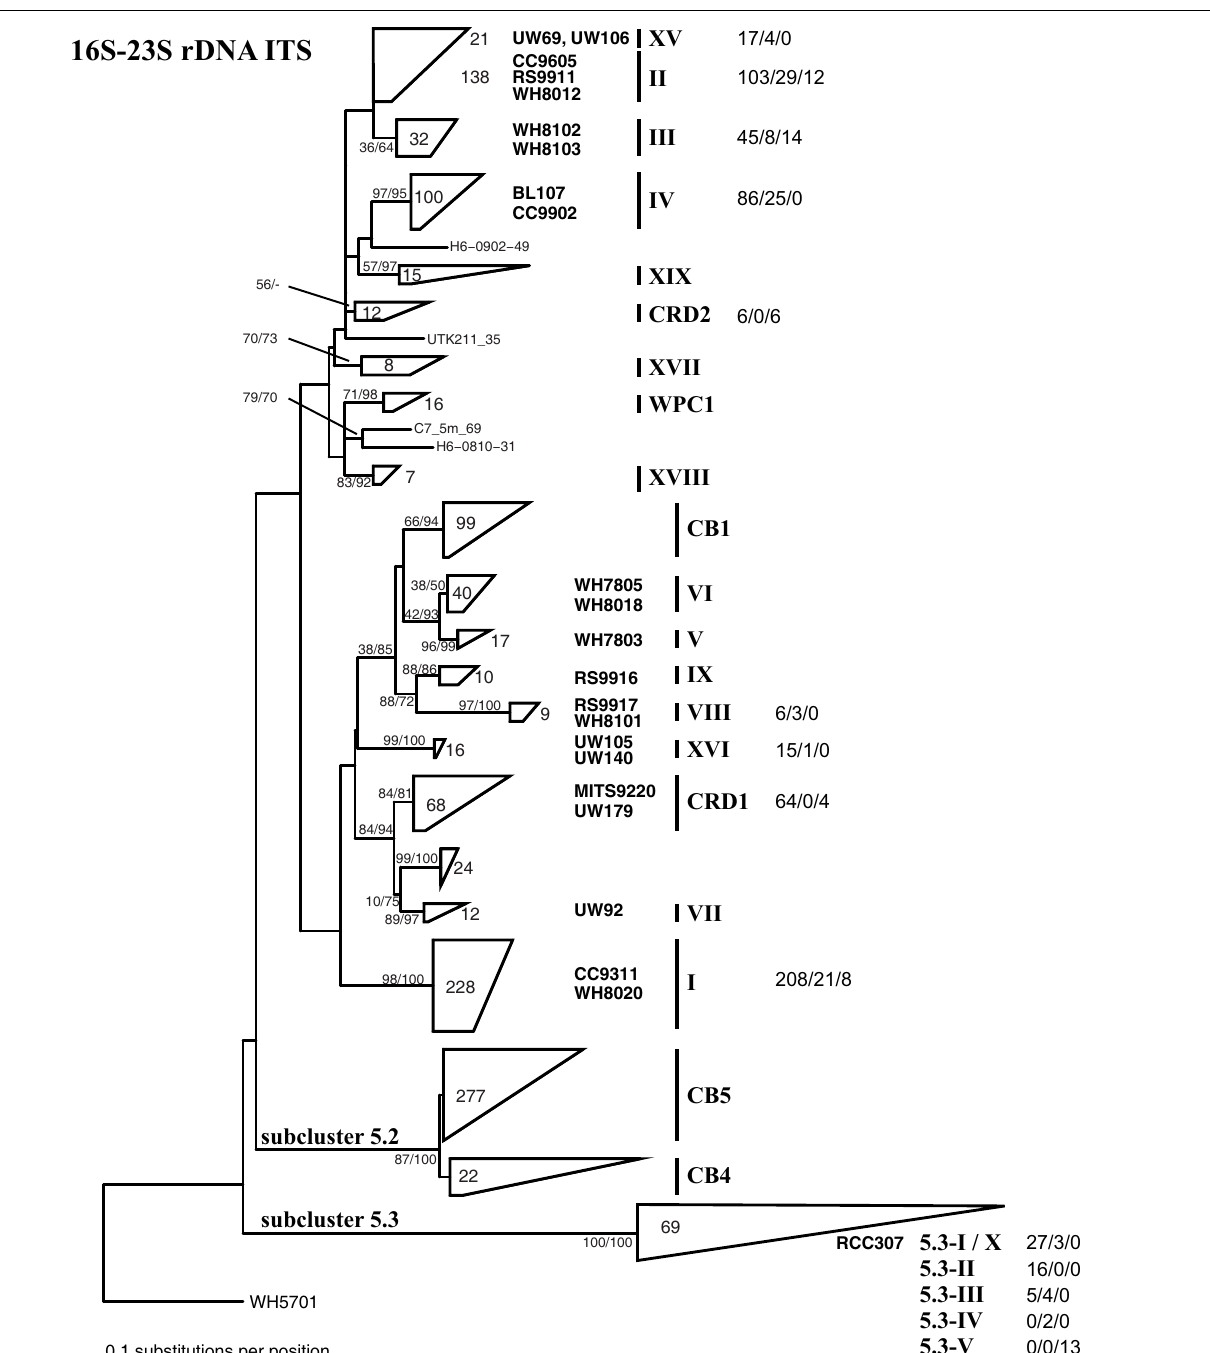
FIGUREA2 | Phylogenetic tree based on 322 positions of the 16S–23S rDNA ITS. The tree shown is the best scoring tree, as determined by maximum likelihood score, amongst 1000 neighbor joining trees constructed using the HKY + i + g substitution model and with randomized addition of taxa. Clade groupings shown in this neighbor joining tree are also supported by bootstrap analysis using maximum likelihood with the GTRGAMMA model in RAxML (1000 replicates) and neighbor joining and the HKY + i + g substitution model (1000 replicates). Nodes display bootstrap values (ML/NJ) where bootstrap support is > 50% in at least one method. Clades were collapsed into groups represented by